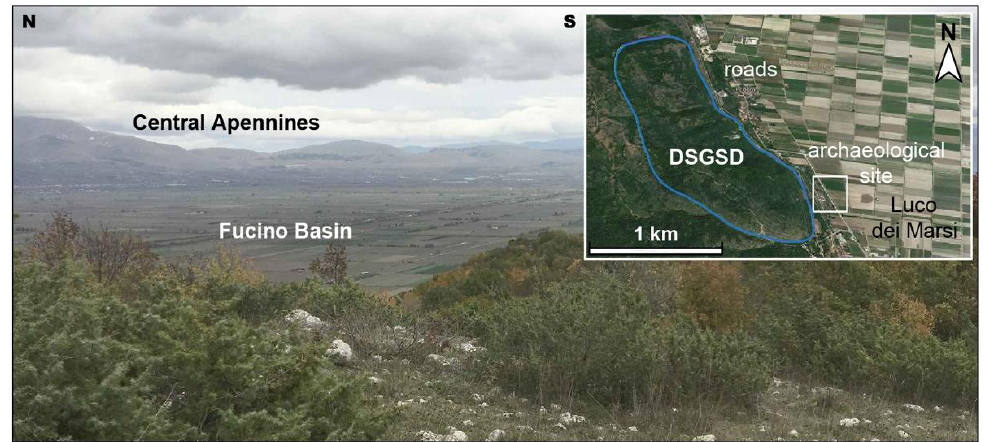
Figure 1. Panoramic view of the Fucino Basin, taken from the Luco dei Marsi ridge (from SW). The insert contains a panoramic view (produced with Google Earth) of the DSGSD, and the main anthropic elements present in the study area.